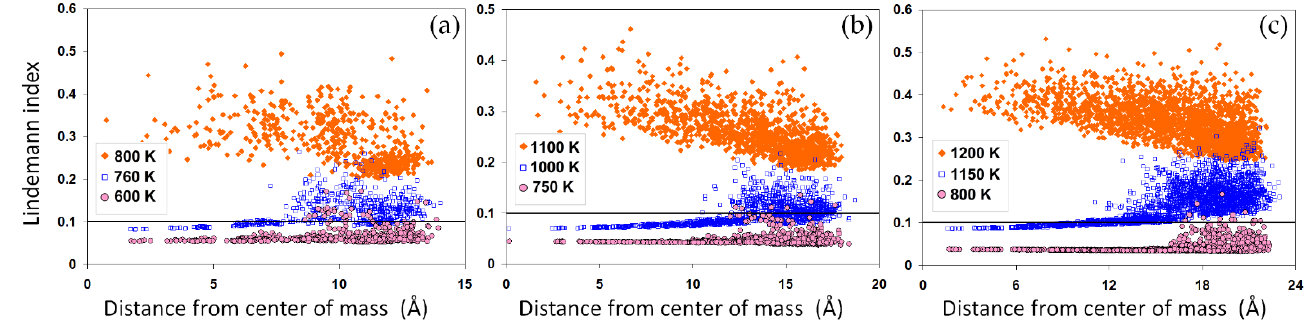
Figure 4. The radial distribution of atomic LI within nanoparticles. The LI distributions are shown for systems with ( a ) 586, ( b ) 1289 and ( c ) 2406 atoms for three temperatures below and at their corresponding melting point. For all systems, a distinct change in the distribution pattern is observed for melted nanoparticles, while a surface premelting (melting below the nominal melting point) is evidenced by the temperature-dependent increase in the LI of the surface atoms. The horizontal line marks the critical LI value 0.1.